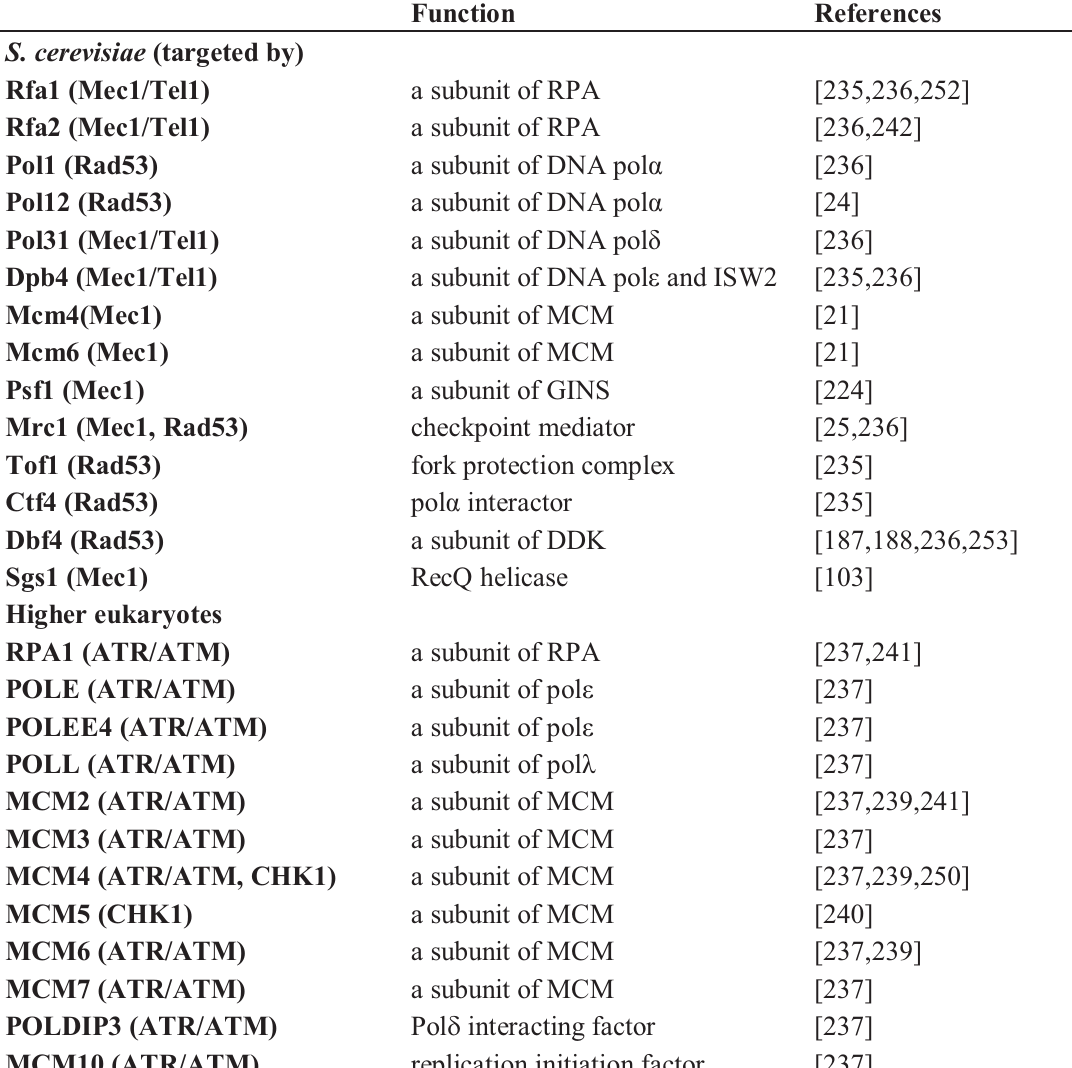
Table 3. Replication factors modified by replication and damage checkpoint